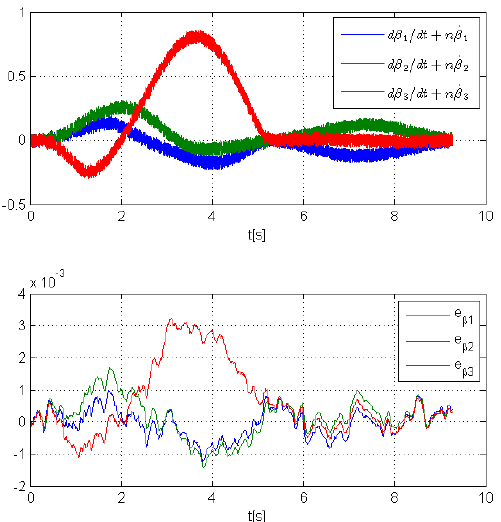
.    β + n . , e using the controller (70) with a = 5. using the controller (70) with 5 a  . Figure 25. Time histories of  β 